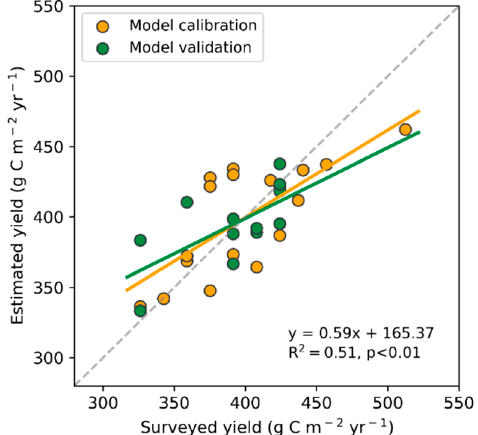
Figure 3. Surveyed and estimated winter wheat yield at 30 sites. The yellow and green dots represent model calibration and validation sites, and the yellow and green solid lines are the regression lines of model calibration and validation, respectively. The grey dashed line is the 1:1 line.